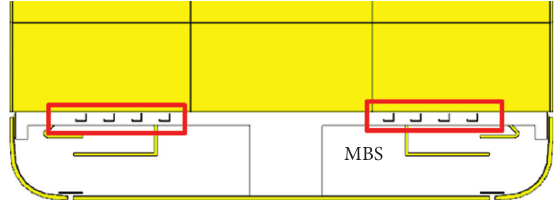
Figure 16: Chosen MBS antenna placement for MIMO perfor- mance